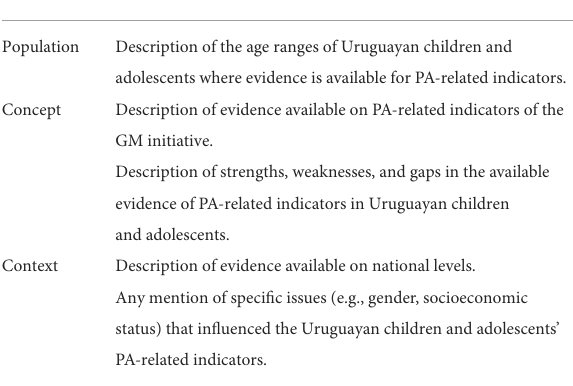
TABLE 1 Data collection domains for data extraction and